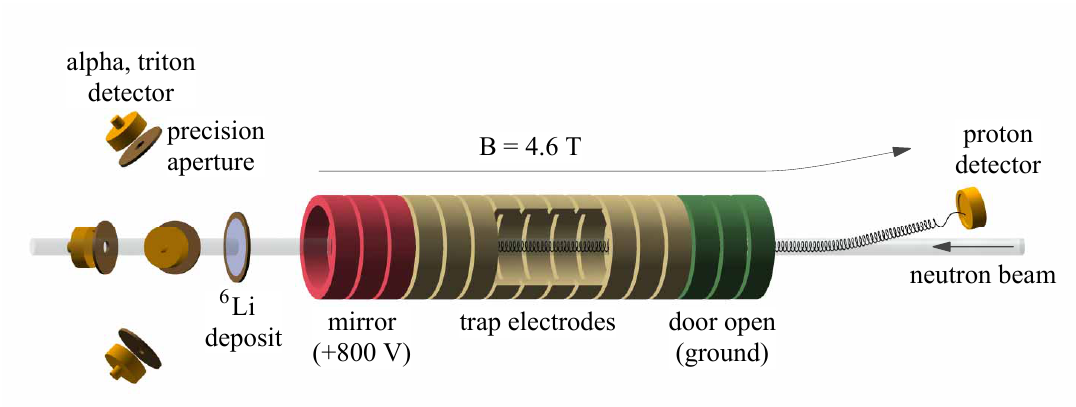
Figure 2. Scheme of the beam neutron lifetime experiment using the Sussex-ILL-NIST method [25]. The neutron beam passes through a segmented quasi-Penning trap. Decay protons are trapped by the elevated door and mirror electrode potentials and counted periodically by lowering the door to ground as shown. Neutrons are counted by detecting the alphas and tritons from the ( n , α ) reaction in a